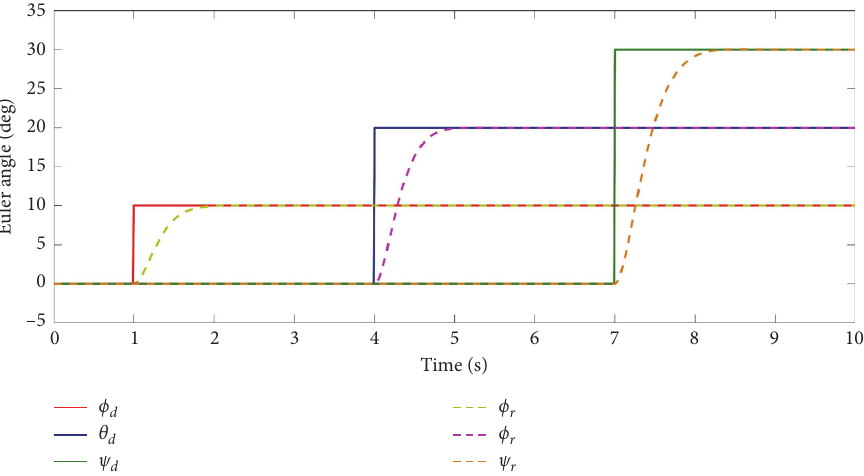
Figure 7: Attitude tracking